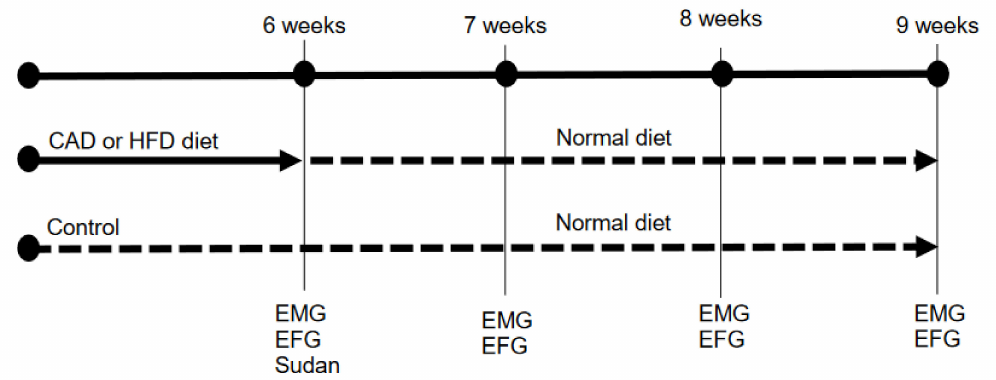
Figure 1. Timeline of the experimental procedure. CAD, cafeteria diet; HFD, high-fat diet; EMG, electromyography (endplate noise recordings); EFG, electrophysiology (intracellular recordings). The diets supplied were: